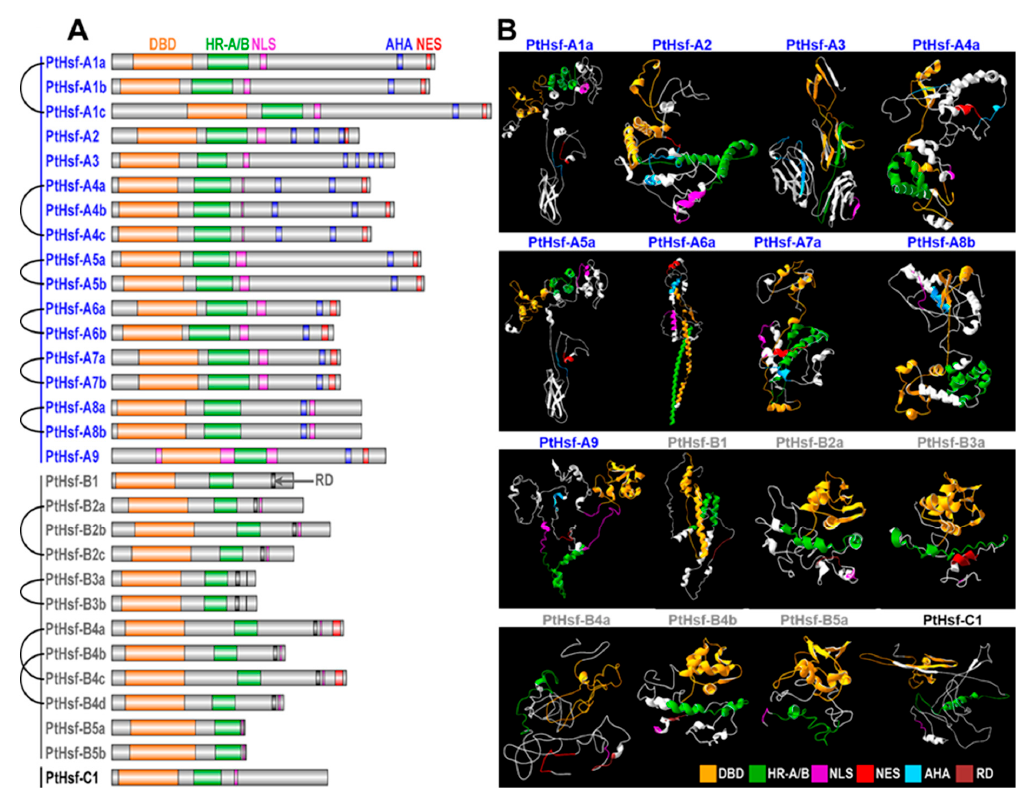
Figure 6. The conserved protein motifs and 3D structures of PtHsf proteins. ( A ) The diagram represents the motif domain distribution in PtHsfs. ( B ) Structural analysis of PtHsf proteins. Protein 3D structure of PtHsfs from each subfamily and each subclade were predicted.